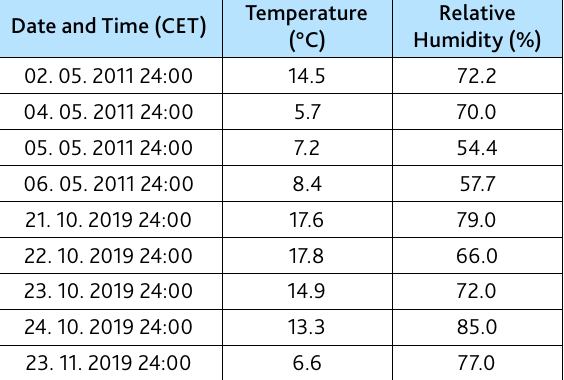
Table 1. Meteorological data for the days of measurement at midnight (meteorological station of the University of